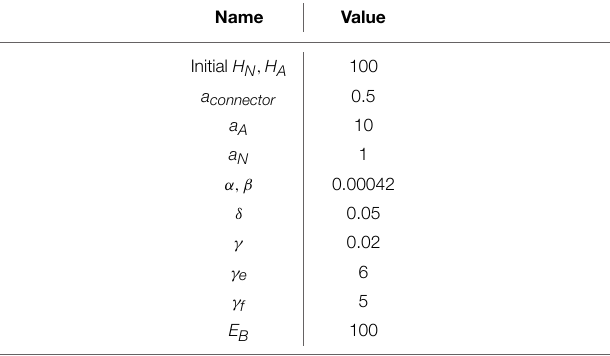
TABLE 2 | Constants used in the computational implementation of the